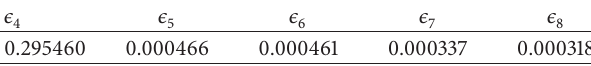
Table 8: 𝜖 𝑁 = √∫ 4, 5,6, 7, 8 of Genocchi polynomials.